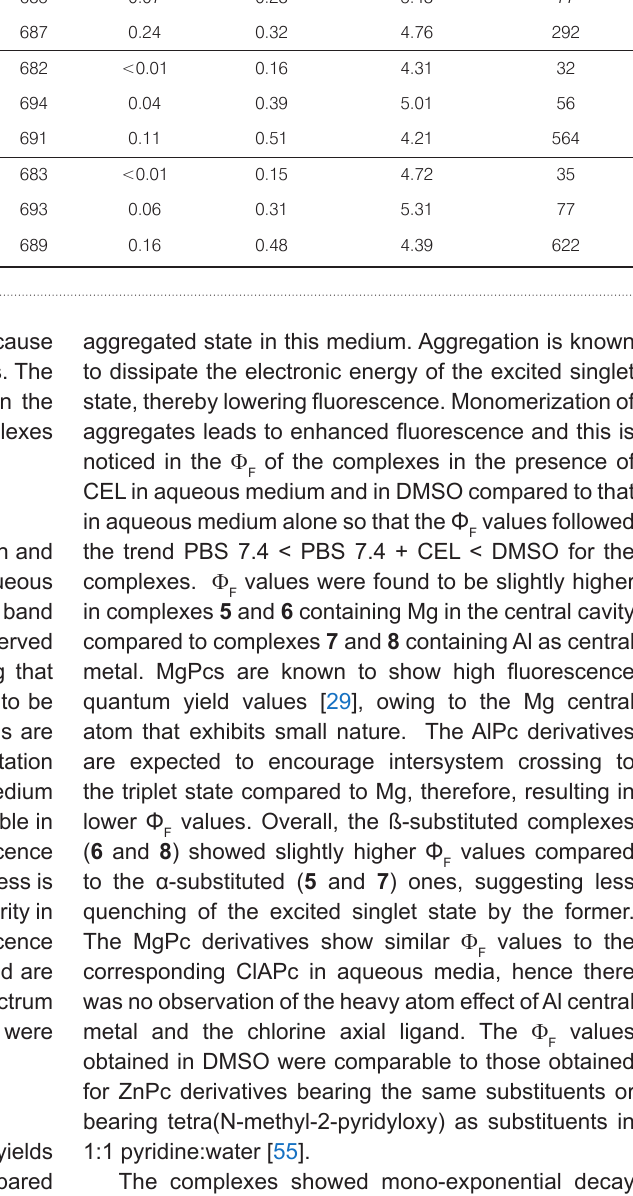
Table 1 . The fluorescence lifetime values fall within